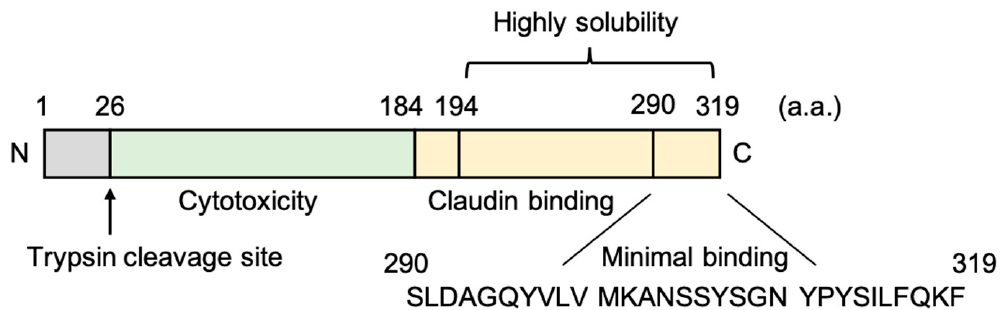
Figure 3. Structure of Clostridium perfringens enterotoxin [71]. The GenBank protein accession number is ADE93025.